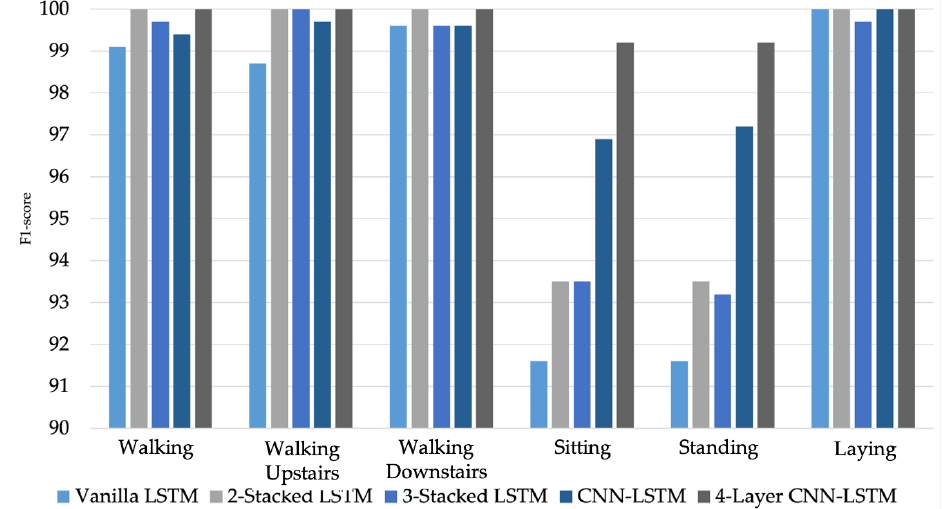
Figure 17. Bar chart showing F1-score of the different LSTM networks on the UCI-HAR dataset.